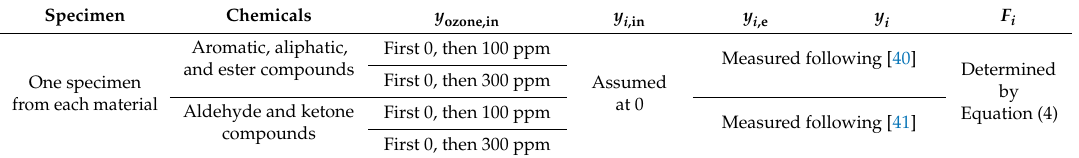
Table 4. The testing procedure for primary and secondary VOC